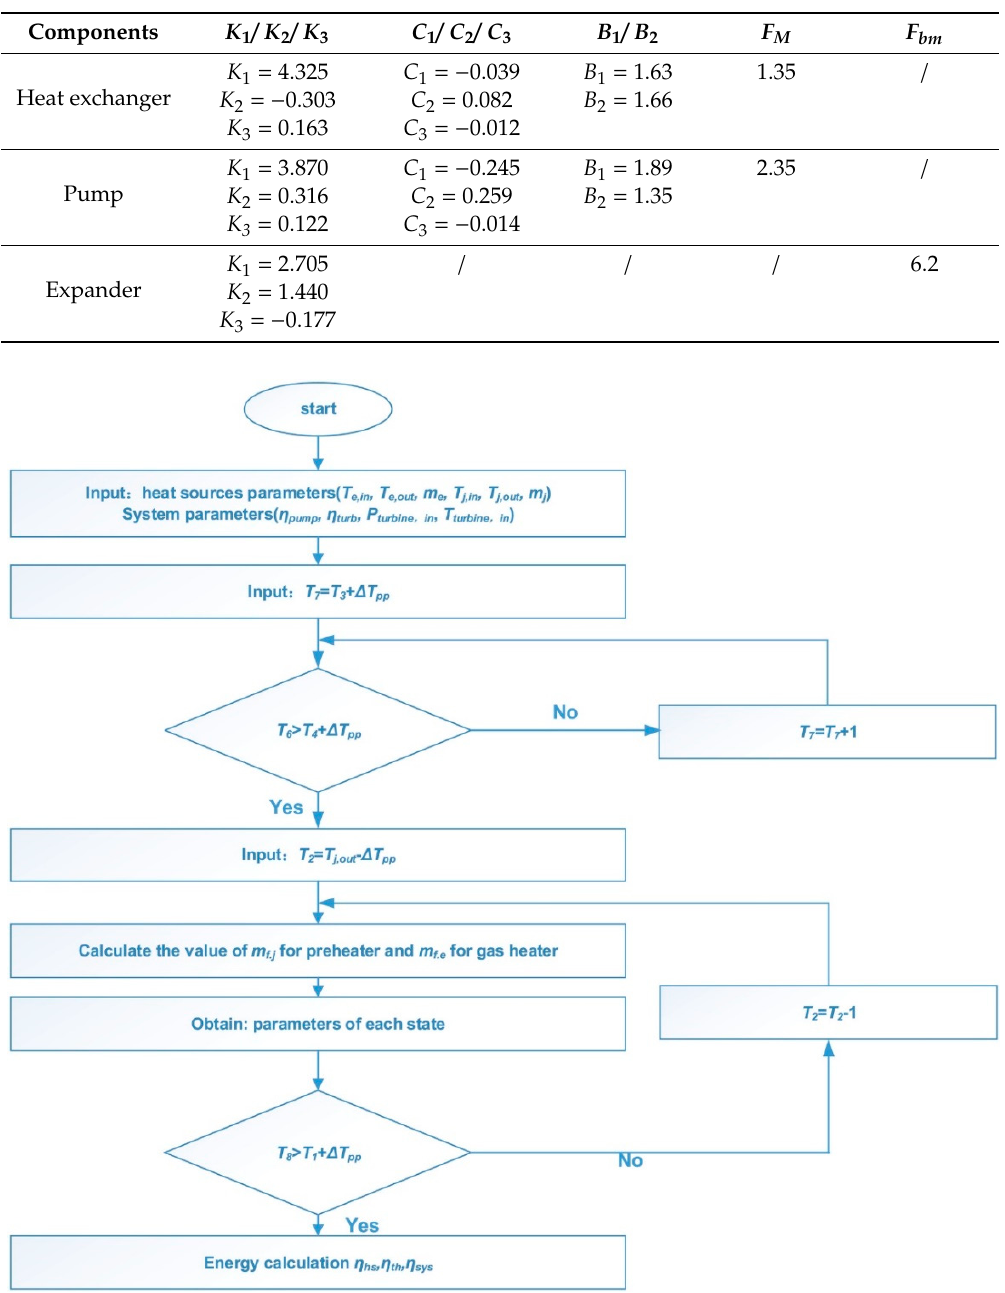
Table 5. Calculation coe ffi cients of the components.